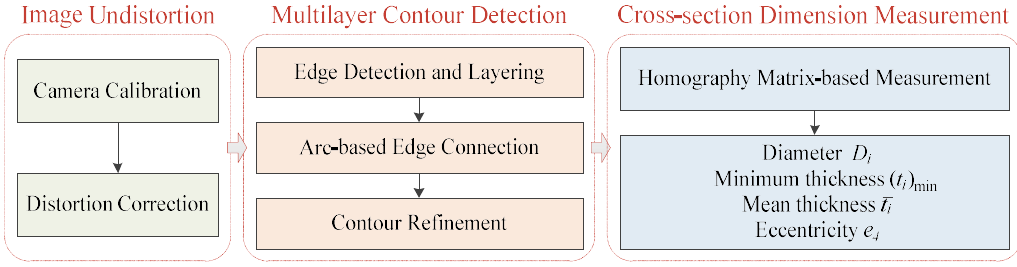
Figure 2. Flow diagram of the proposed vision-based framework for power cable cross-section